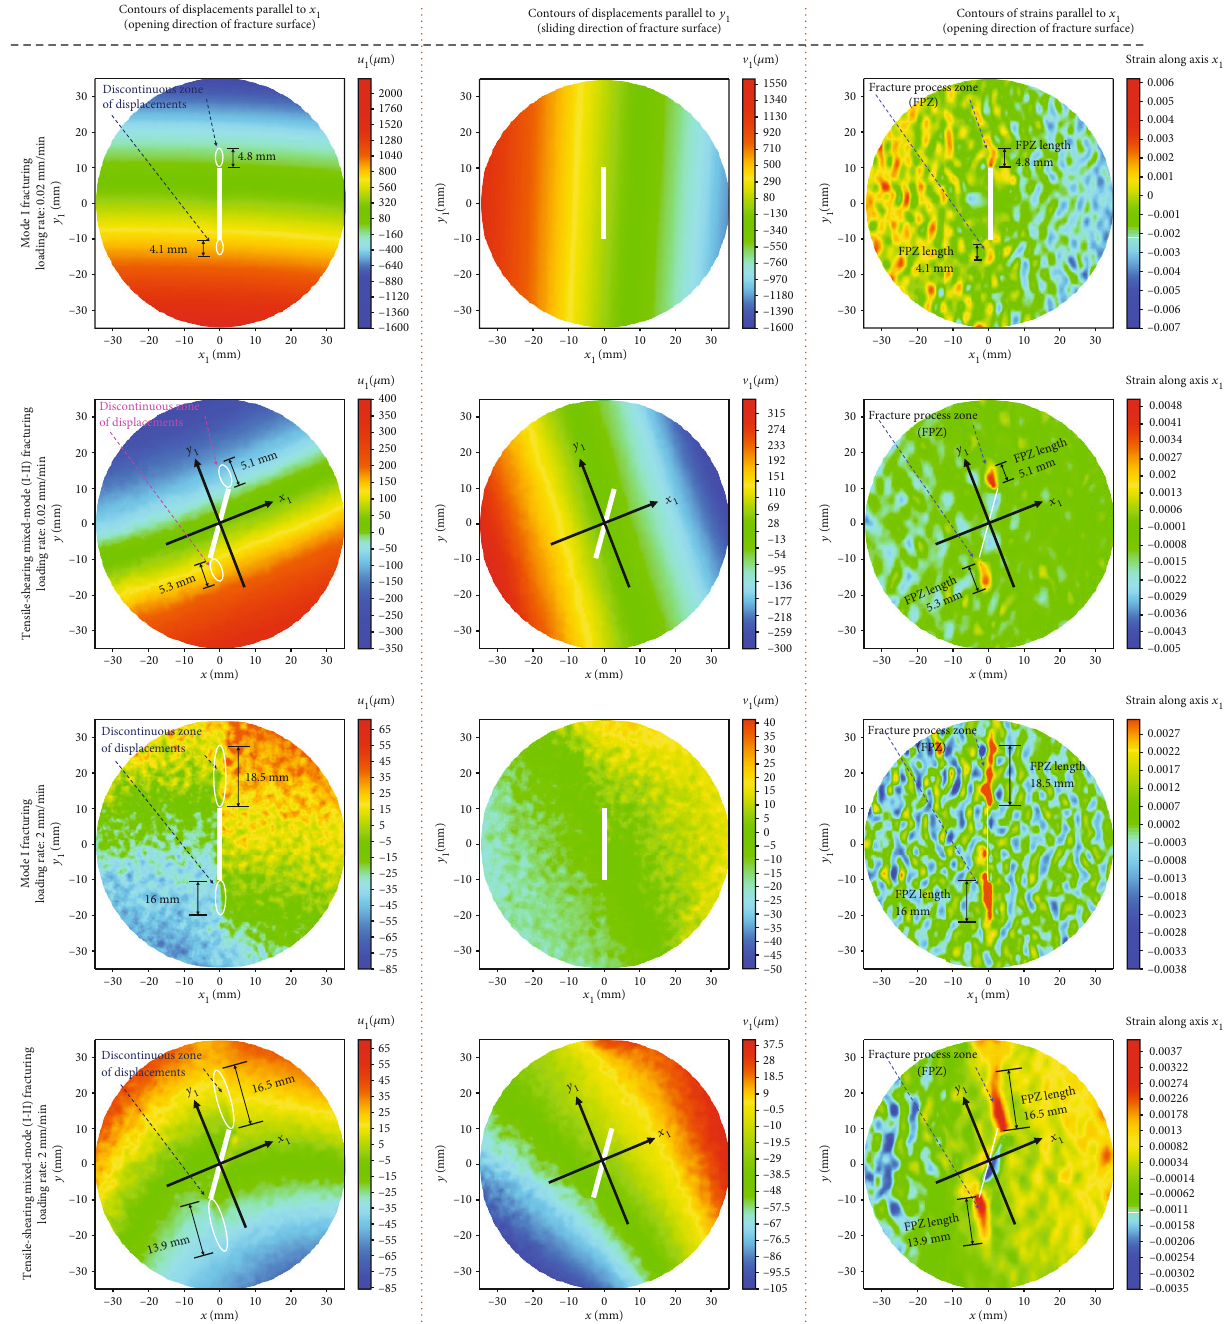
Figure 2: DIC-based displacement and strain fi elds of Mixed-mode (I-II) and pure mode I fracturing at di ff erent quasistatic loading rates (replotted based on our recently published work